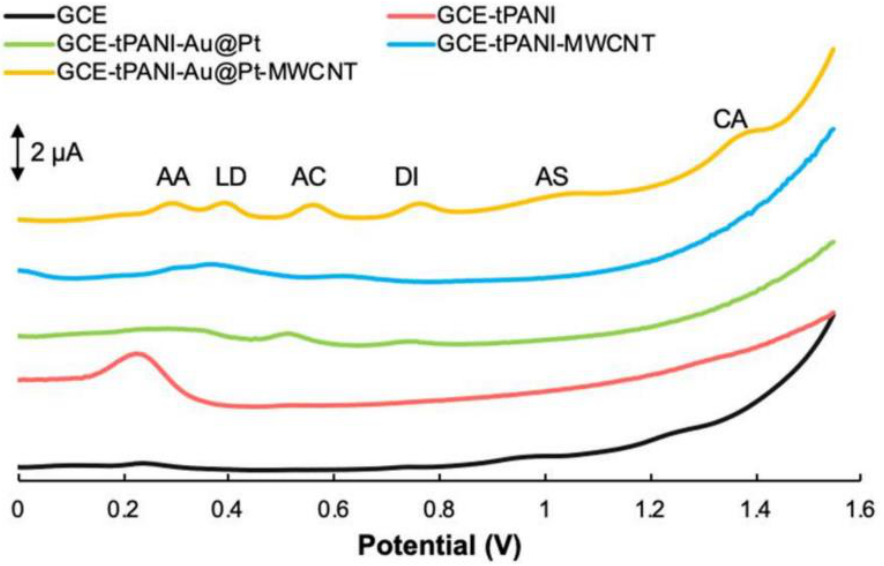
Figure 4. DPVs for the electrochemical oxidation of ascorbic acid (AA) (150 µ M), levodopa (LD) (15 µ M), acetaminophen (AC) (15 µ M), diclofenac (DI) (15 µ M), acetylsalicylic acid (AS) (150 µ M), and caffeine (CF) (150 µ M) at the blank GCE (black line), tPANI-modified GCE (red line), tPANI-Au@Pt-modified GCE (green line), tPANI-MWCNT-modified GCE (blue line), and tPANI-Au@Pt-MWCNT-modified GCE (yellow line) in 0.5 M PBS (pH 3.0). Reprinted from [59].